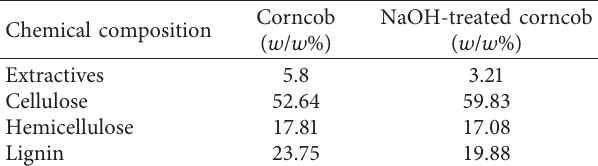
Table 4: Elemental analysis of the catalyst and bamboo